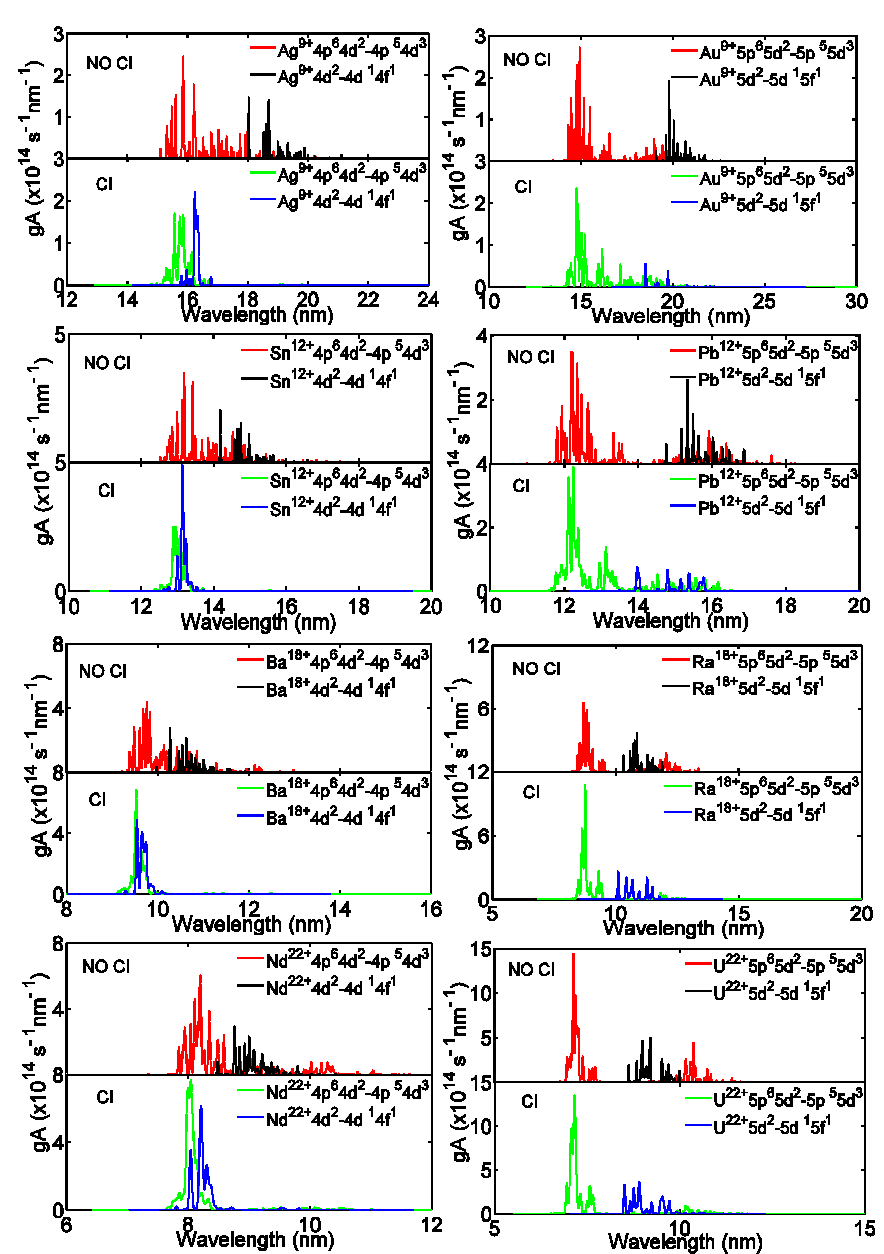
Figure 5. (Color online) Gaussian convolved spectra of 4p 6 4d 2 − 4p 5 4d 3 +4p 6 4d 1 4f 1 transitions in Sr-like Ag 9+ , Sn 12+ , Ba 18+ , and Nd 22+ and 5p 6 5d 2 − 5p 5 5d 3 +5p 6 5d 1 5f 1 transitions in the homologous ions Au 9+ , Pb 12+ , Ra 18+ , and U 22+ of the Yb-isoelectronic sequence.